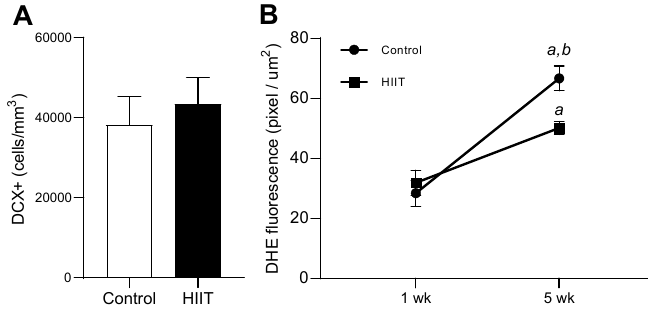
Figure 6. E ff ect of five-week HIIT on the DCX + cells and SO levels in dentate gyrus. ( A ) Quantification of DCX + cells and in the dentate gyrus (control n = 10; HIIT n = 10). ( B ) Superoxide anion levels in the dentate gyrus: 1 wk—HIIT for one week, 5 wk—HIIT for five weeks. Statistical analyses were performed by the Student’s t -test. * p < 0.05 (Figure A), and Analysis of variance (ANOVA) one-way Bonferroni post-hoc (Figure B), a p < 0.05 vs. Control 1 wk; b p < 0.05 vs. HIIT 1 wk;.